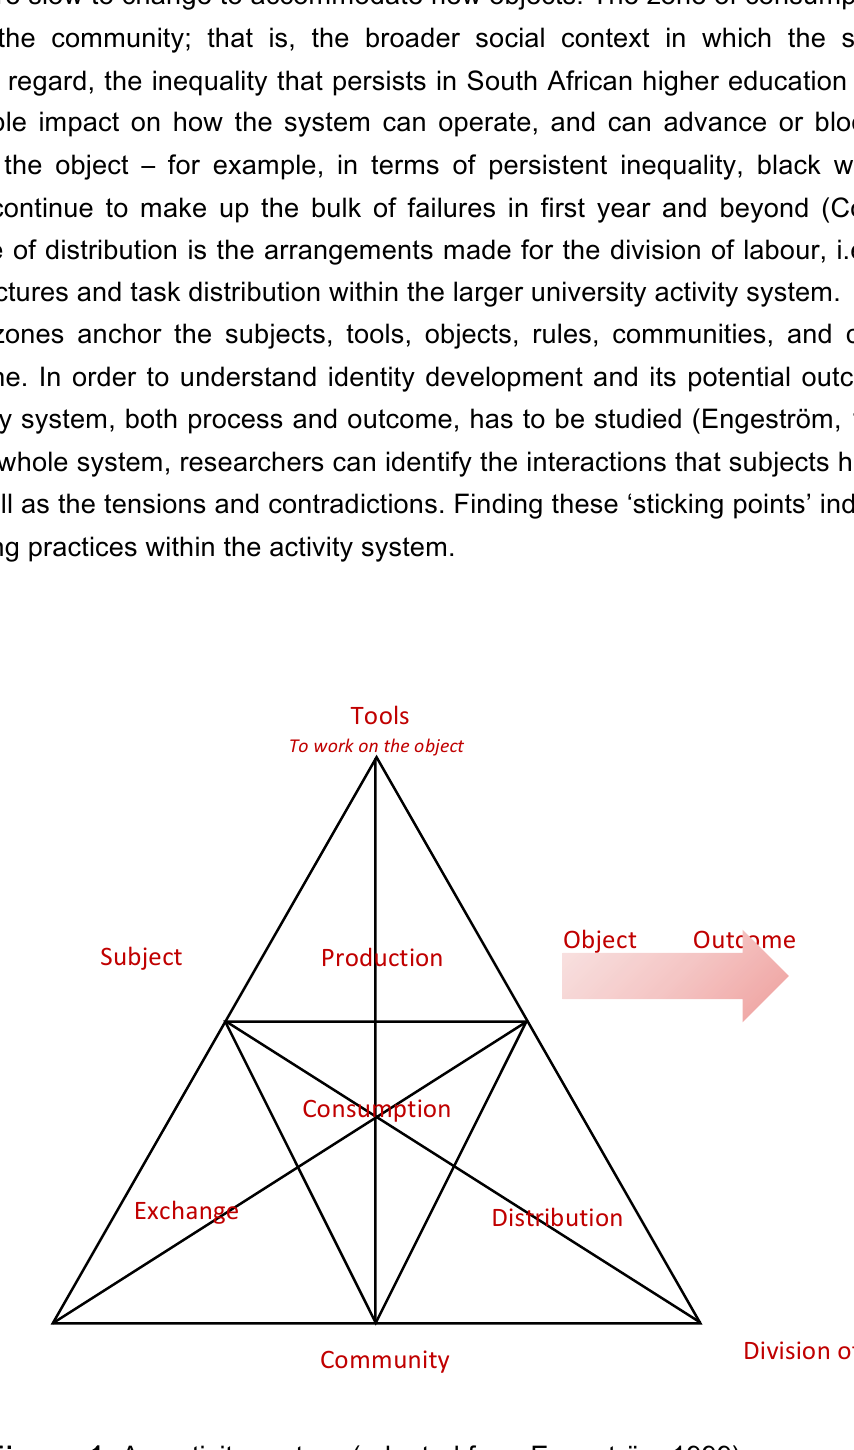
Figure 1: An activity system (adapted from Engeström 1999)